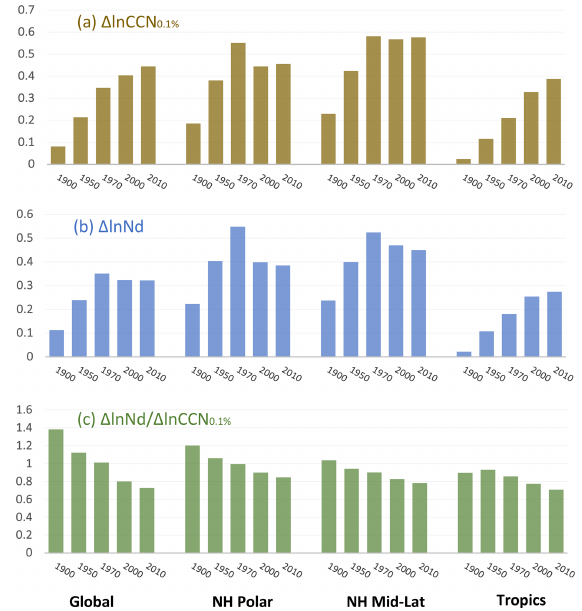
Figure 9. Global and regional annual mean relative changes in CCN ( (cid:49) lnCCN 0 . 1% , a ) and N d ( (cid:49) ln N d , b ) due to differences in anthropogenic aerosols between PI (1850) and PD (2010). Panel (c) shows the ratio between (cid:49) ln N d ) and (cid:49) lnCCN 0 . 1% . See Sect. 4.2 for